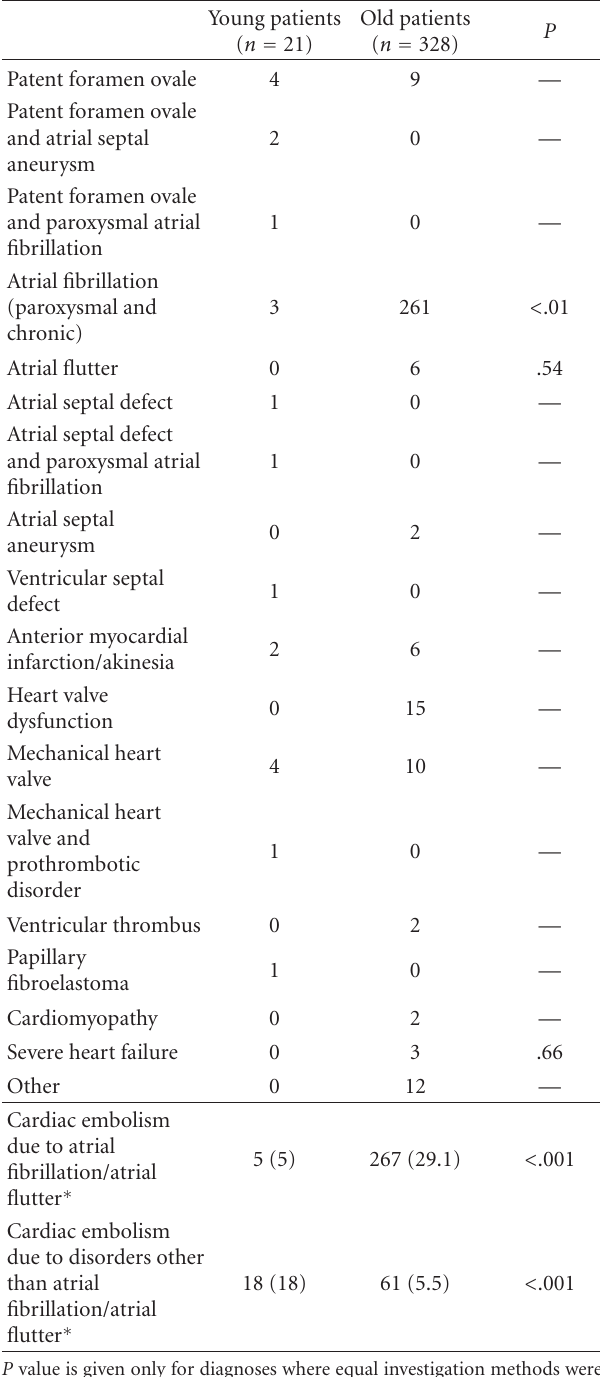
Table 3: Heart disorders associated with cardiac embolism. Table 4: Other causes of cerebral infarction.